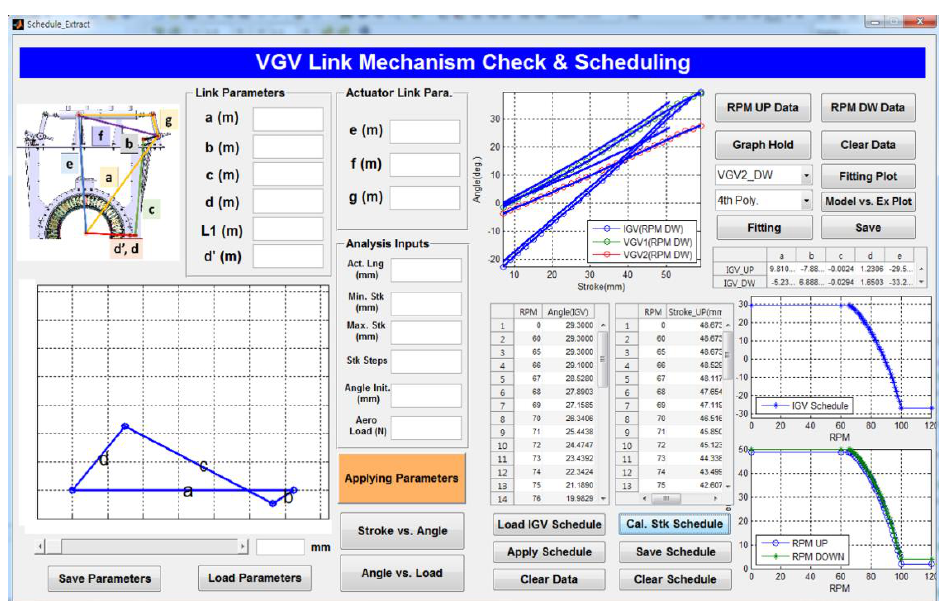
Figure 8. VGV scheduling methodology flow chart.